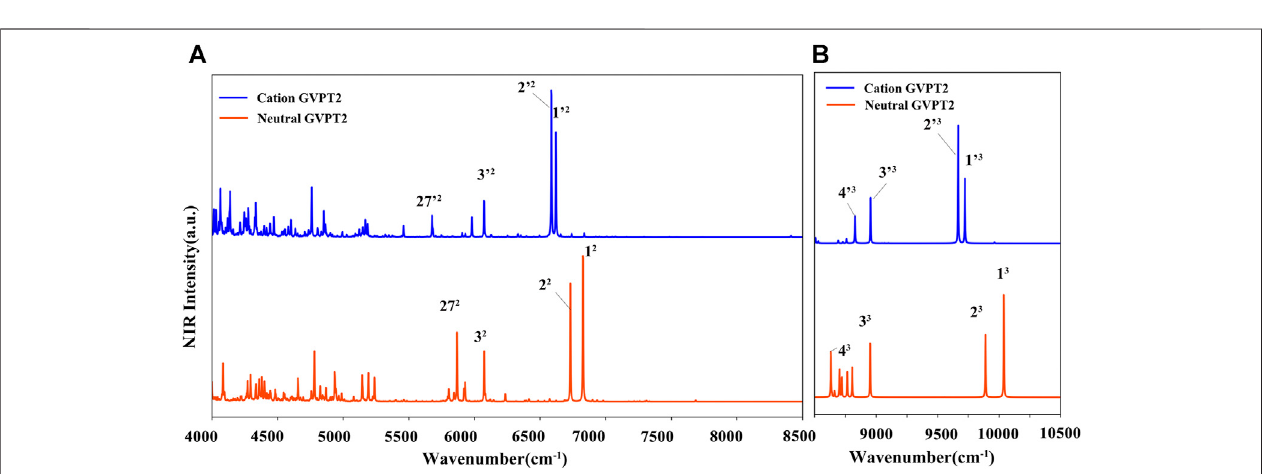
Frontiers in Astronomy and Space Sciences |